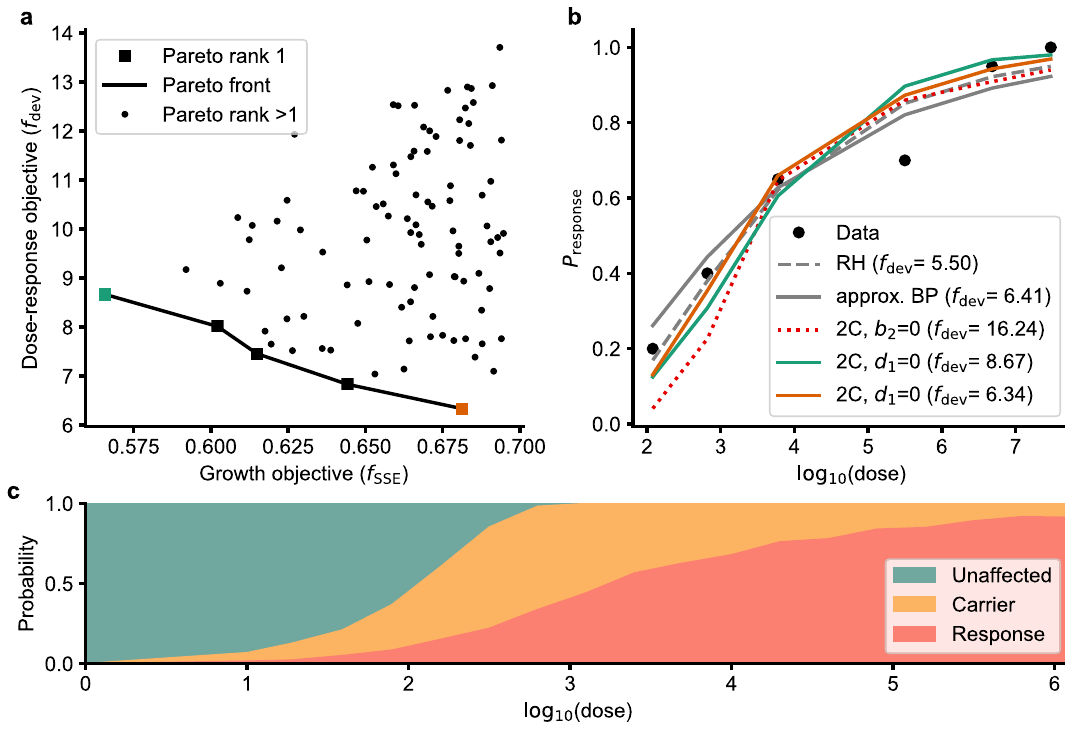
Figure 3. 2C stochastic model fit and parameters. ( a ) Comparison of fits to the growth data ( f SSE ) and dose- response data ( f dev ). ( b ) Dose-response probabilities for the 2C model cases, along with RH and aBP models. Two colored 2C models with d 1 = 0 are the solutions at the extremes of the Pareto front in A. ( c ) Outcome probabilities as a function of dose for the 2C model with d 1 = 0 and f dev = 6.34 .